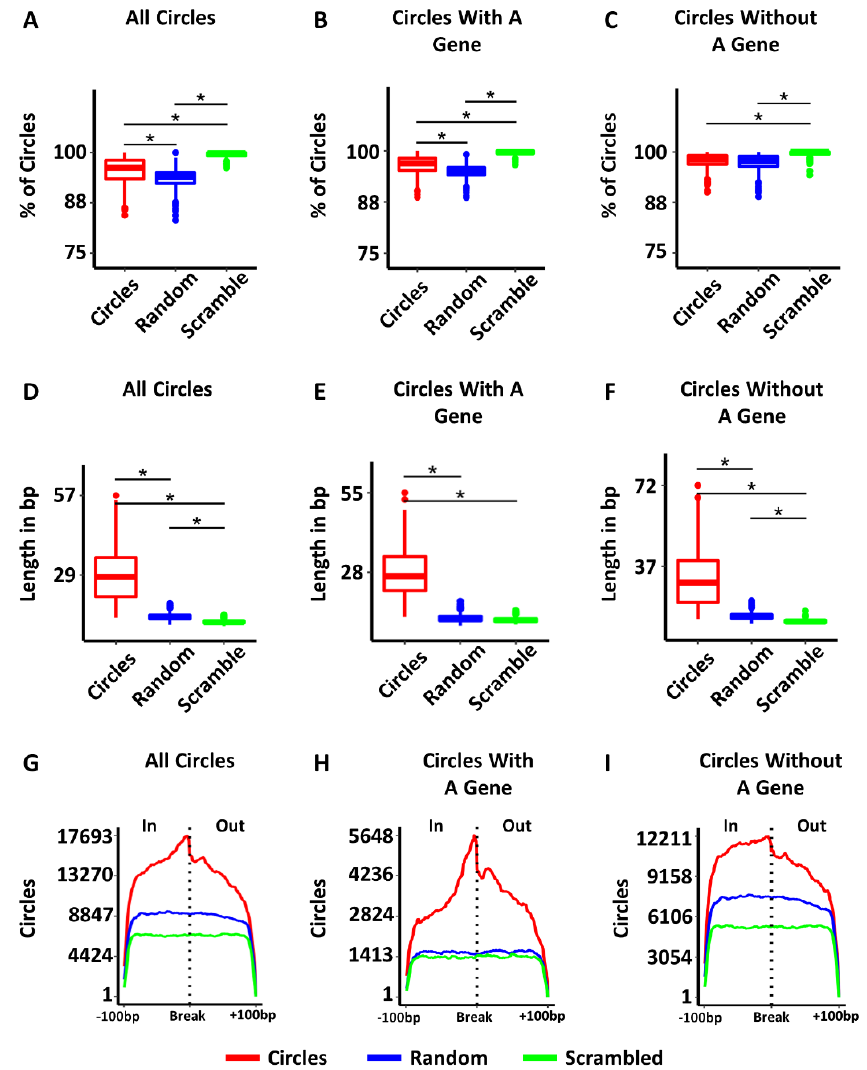
Figure 5. Circles are self-microhomologous. ( A ) Percent of circles with self-microhomology compared to random and scrambled controls. ( B ) Percent of circles with genes with self-microhomology compared to random and scrambled controls. ( C ) Percent of circles without genes with self-microhomology compared to random and scrambled controls. ( D ) Length of microhomology in bp for circles compared to random and scrambled controls. ( E ) Length of microhomology for circles with genes compared to random and scrambled controls. ( F ) Length of without genes compared to random and scrambled controls. ( G ) Traces showing the position of microhomology with respect to the circle breakpoint for all circles, random and scrambled controls. ( H ) Traces showing the position of microhomology with respect to the circle breakpoint for circles with genes, random and scrambled controls. ( I ) Traces showing the position of microhomology with respect to the circle breakpoint for all circles without genes, random and scrambled controls. Significance was calculated by ANOVA, with a post-hoc Tukey test. * indicates p -values less than 0.05.